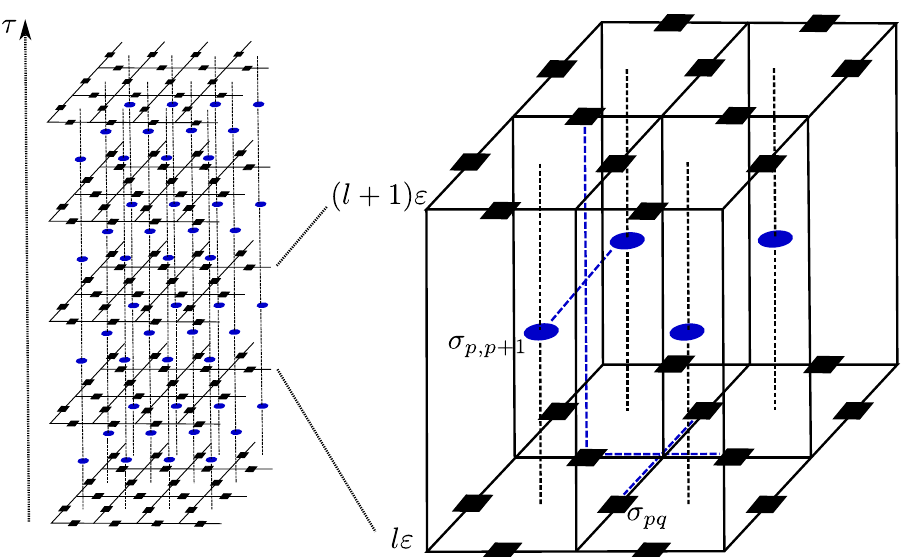
Figure 3: Left: After implementing the Suzuki-Trotter decomposition, we obtain a partition function describing classical interacting spins in 3 D . The third dimension corresponds to spin values at point of time k ∆ τ and ( k + 1 ) ∆ τ in the Suzuki-Trotter decomposition, where k = 0,1,2... M − 1 (see Eq. 6). Right: If we focus on one imaginary time period, we can see the new degrees of freedom s x , renamed to σ , p , p + 1 p that emerged in the computation of the partition function. The new spins participate in the classical 3 D Hamiltonian in A -like terms and bond-like terms in the temporal s